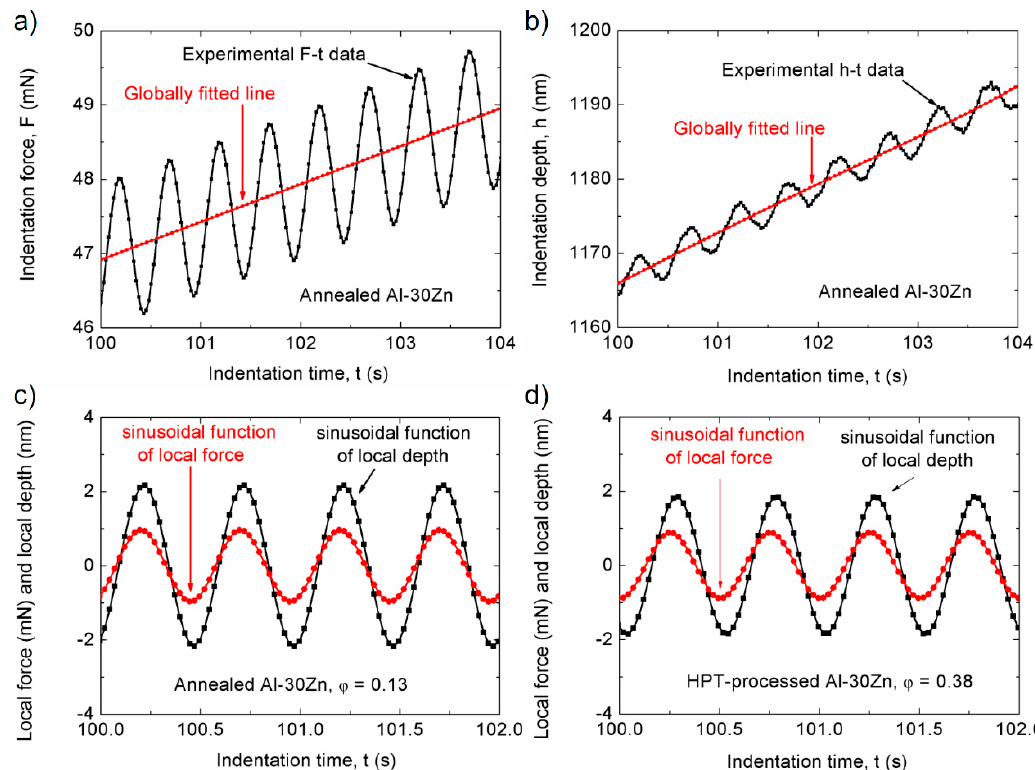
Figure 11. Main steps of the evaluation of the phase shift from the data of dynamic indentation: ( a ) and ( b ) calculation of the oscillatory force and depth signals from the experimental data; ( c , d ) the corresponding sinusoidal signals and the phase shift, ϕ for the annealed coarse-grained and HPT- processed ultrafine-grained Al-30Zn samples. Reproduced with permission from [75]. Copyright 2019, Materials Research Society.